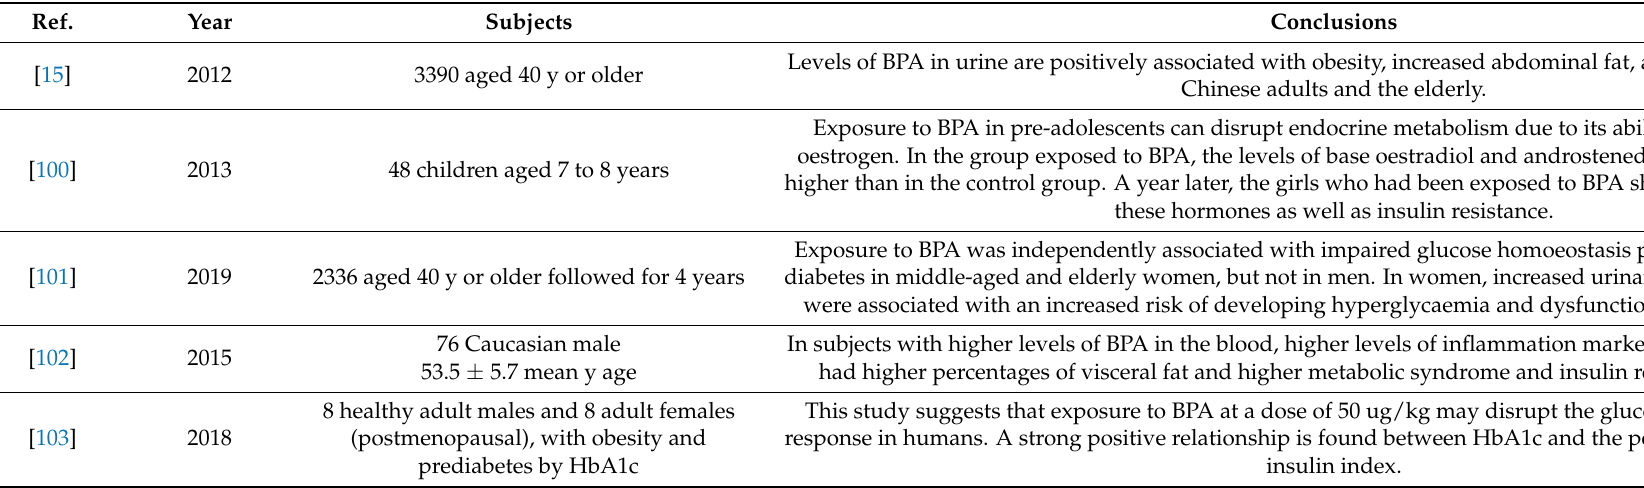
Table 2. Observational studies in